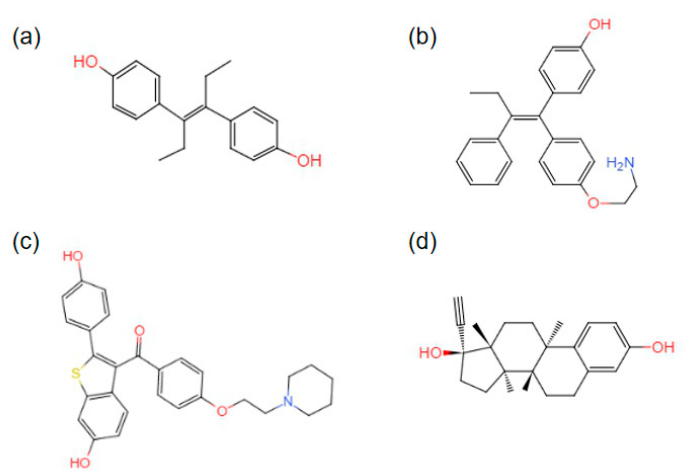
Figure 3. Structures of synthetic therapeutic drugs: ( a ) diethylstilbestrol; ( b ) 4-hydroxytamoxifen; ( c ) raloxifene; and ( d ) ethynylestradiol.